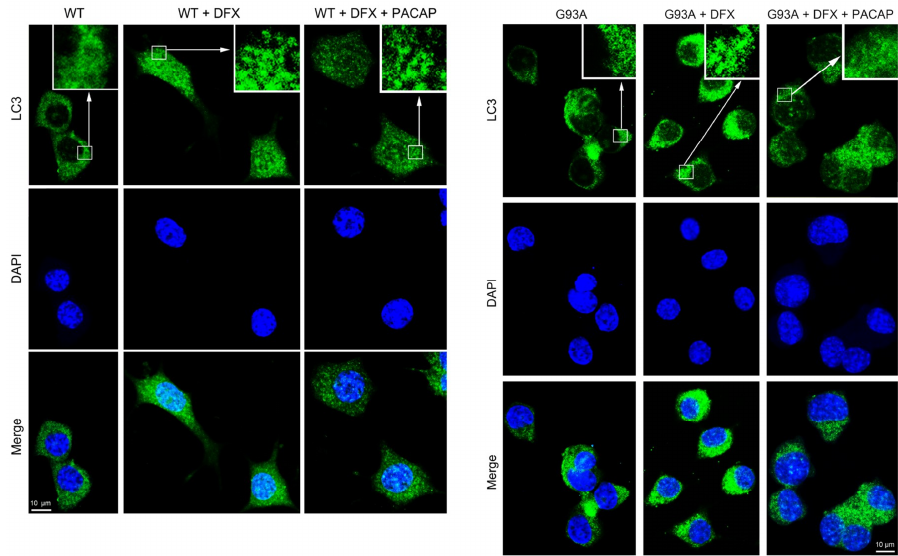
Figure 5. Immunosignal of LC3 protein in the WT and G93A cells exposed for 24h to hypoxia and treated with PACAP. The photomicrographs show the distribution of the LC3 protein in the WT and G93A cultured for 24 h with desferrioxamine mesylate salt (DFX) alone or in combination with PACAP (DFX + PACAP). The cytoplasmic immunofluorescent dots revealed the localization of the LC3 antibody in the autophagic vacuoles. The signal was detected using mouse anti-LC3 primary antibody revealed with the Alexa Fluor 488 secondary antibodies (green fluorescence). Cell nuclei were stained with diamidino-2-phenylindole, DAPI (blue fluorescence). The photomicrographs are representative results taken from different fields in randomly selected slides and scanned by confocal laser scanning microscopy (CLSM). Scale bar (10 µm).